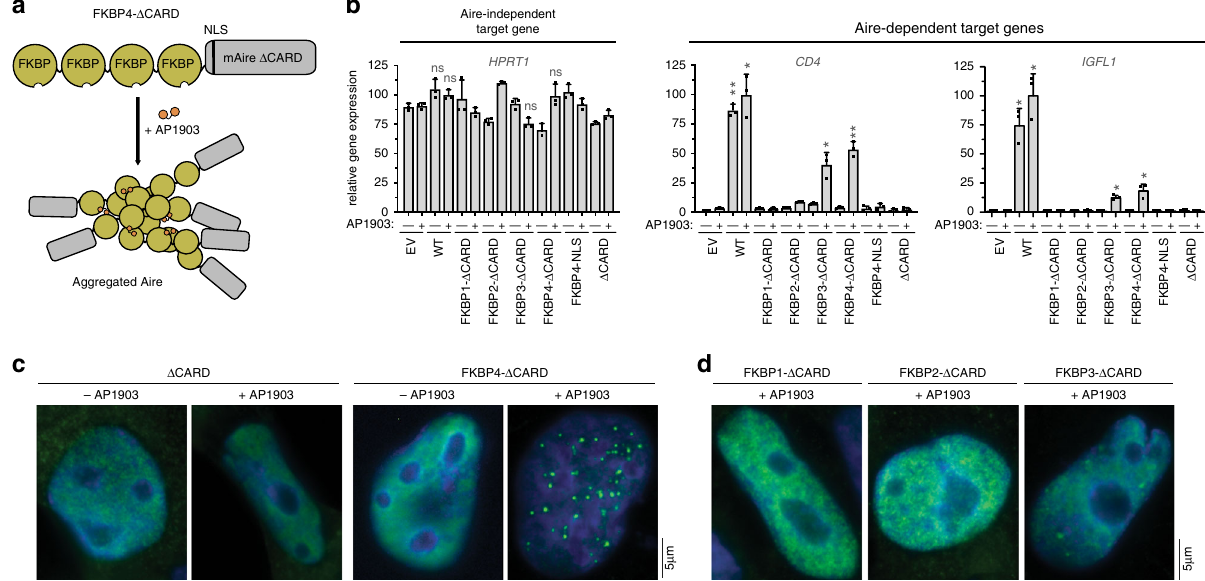
Fig. 2 Chemically induced multimerization partially restores the transcriptional activity of Aire Δ CARD. a Schematic of mAire Δ CARD fused with four tandem repeats of FKBP (FKBP4- Δ CARD). Proteins with FKBP repeats are known to multimerize upon addition of chemical dimerizer AP1903 40 . b Transcriptional activity of Δ CARD fused with 1 – 4 tandem repeats of FKBP (FKBP1 – 4) in the presence and absence of AP1903. Fusion constructs were transiently expressed (using 1.25 μ g/ml DNA) in 293 T cells and DMSO or AP1903 (5 μ M) was added 24 h later. Cells were harvested 48 h after transfection, followed by RT-qPCR of the respective Aire-dependent genes (represented by CD4 and IGFL1 ). The relative mRNA level of an Aire- independent gene, HPRT1 , was also shown as a negative control. Data are representative of at least three independent experiments and presented as mean ± s.d., n = 3. See Supplementary Fig. 2a, b for additional target genes and western blot (WB) showing protein expression levels. P -values (two-tailed t